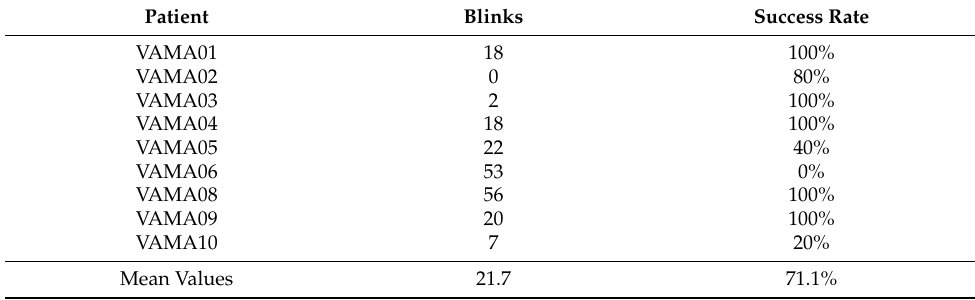
Table 9. Memory-guided saccade test: success rate in post-COVID-19 patients.